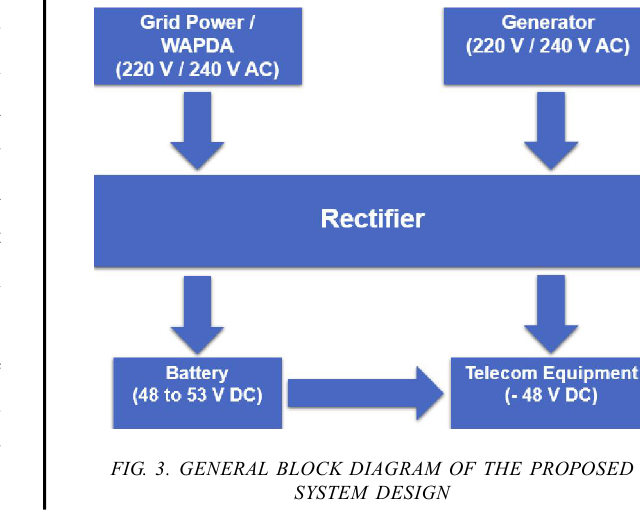
FIG. 3. GENERAL BLOCK DIAGRAM OF THE PROPOSED SYSTEM